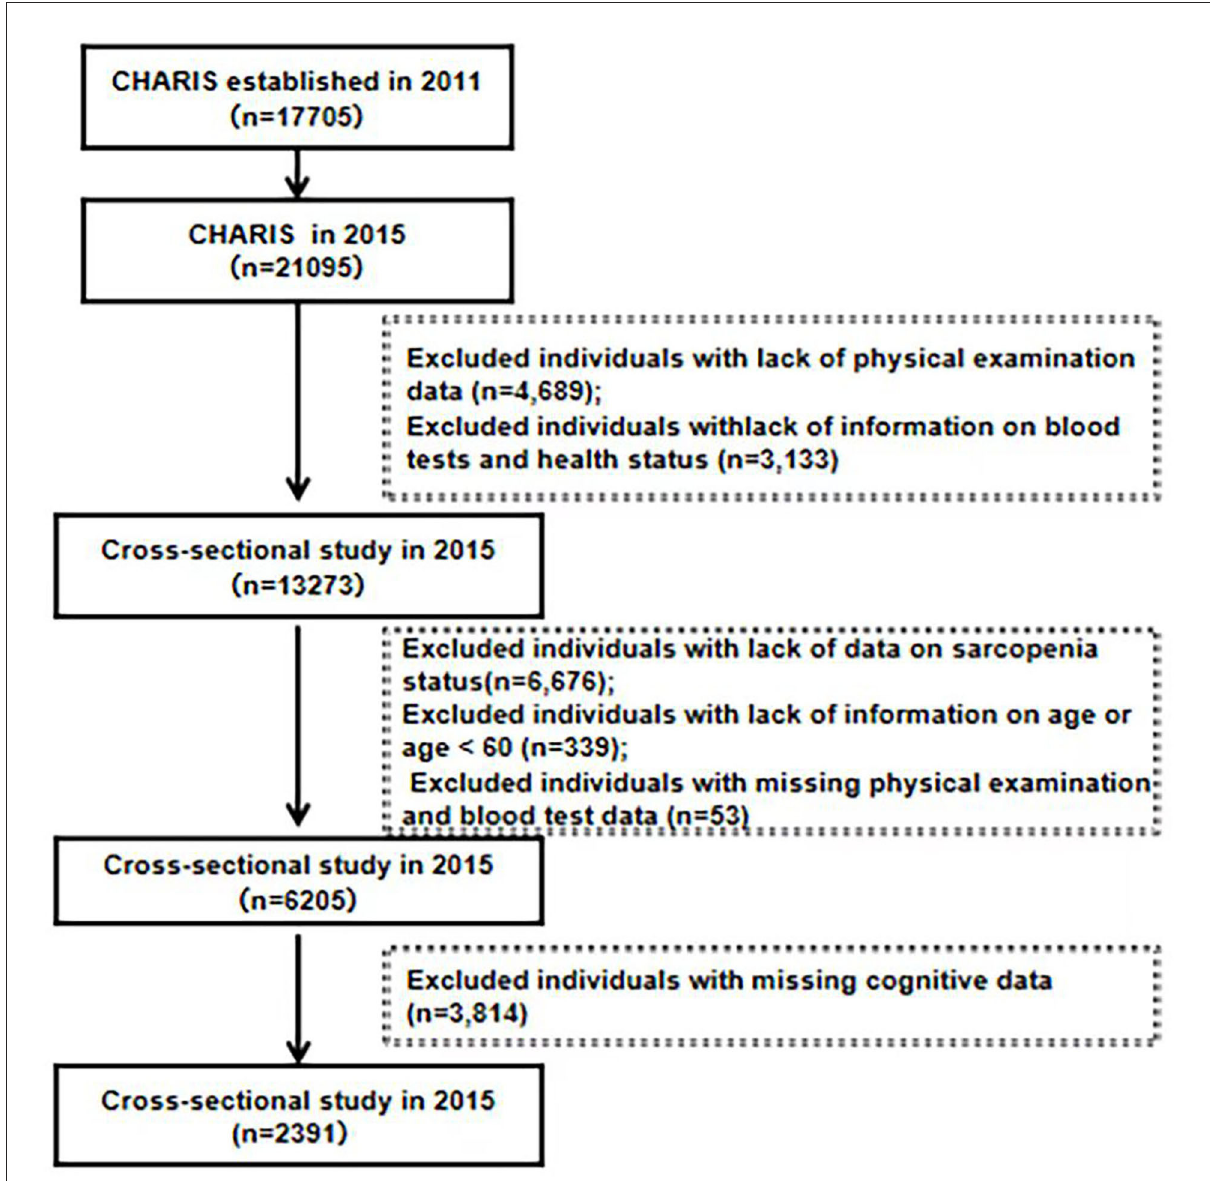
FIGURE1 Flowchart for the study sample. HS, handgrip strength; GS, gait speed; ASM, appendicular skeletal muscle mass, CST, chair stand